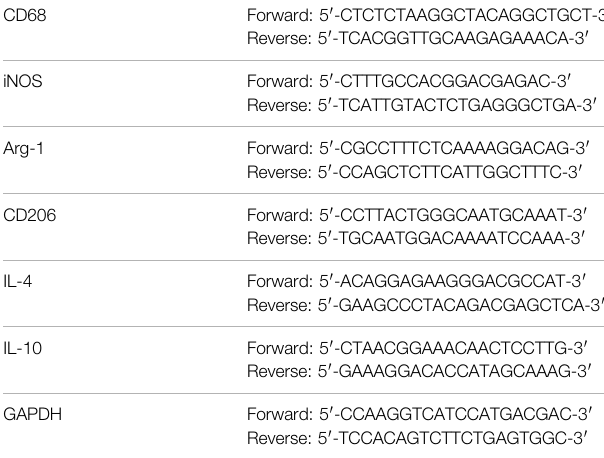
TABLE 1 | The sequence list of mRNA primers for real-time